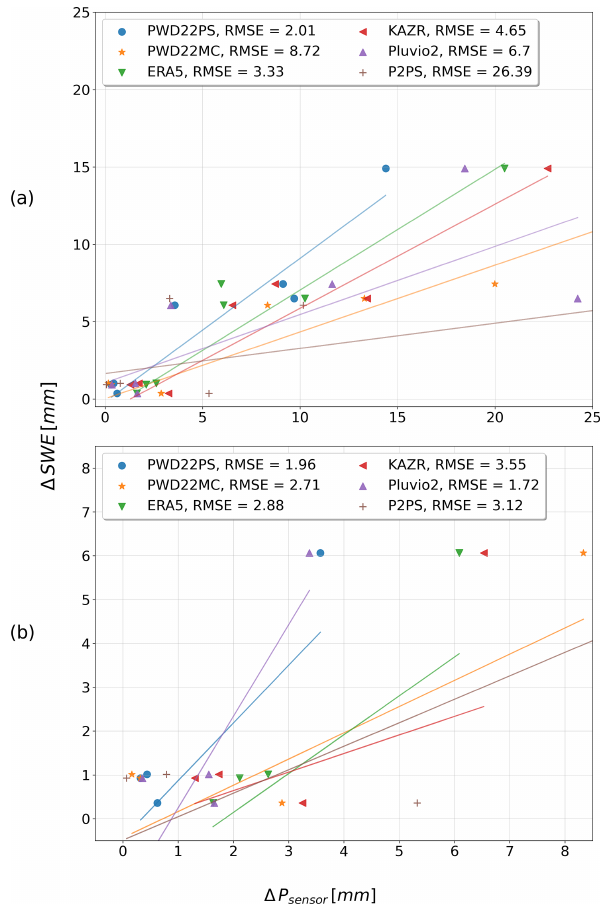
Figure 12. (a) RMSE (mm) of the sensors and ERA5 with respect to snow cover SWE, for the time period before 20 February 2020 with n = 9d of sampling, including days when drifting snow was detected. Panel (b) is as (a) but without days when drifting snow was detected before ( n = 6d). The lines show the linear regression for each